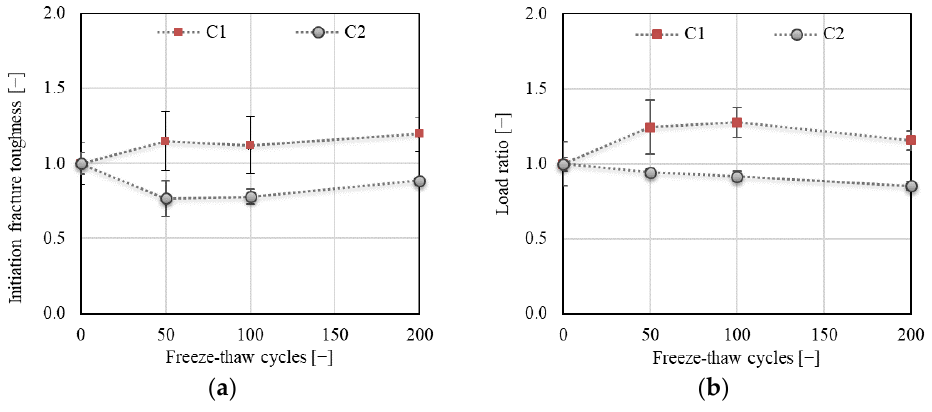
Figure 16. ( a ) Cohesive fracture toughness K Icc ; ( b ) unstable fracture toughness K Icun .